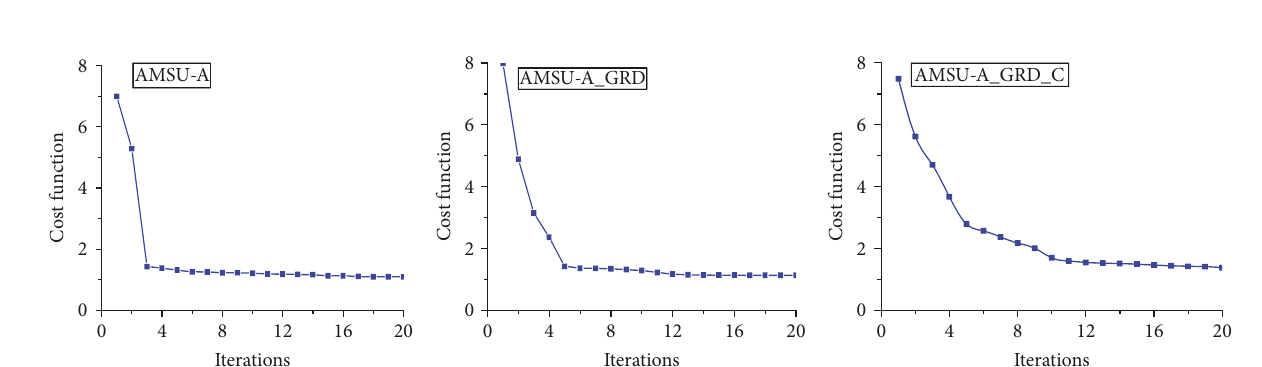
Figure 2: Variations of cost function terms with respect to iterations for ideal experiment.